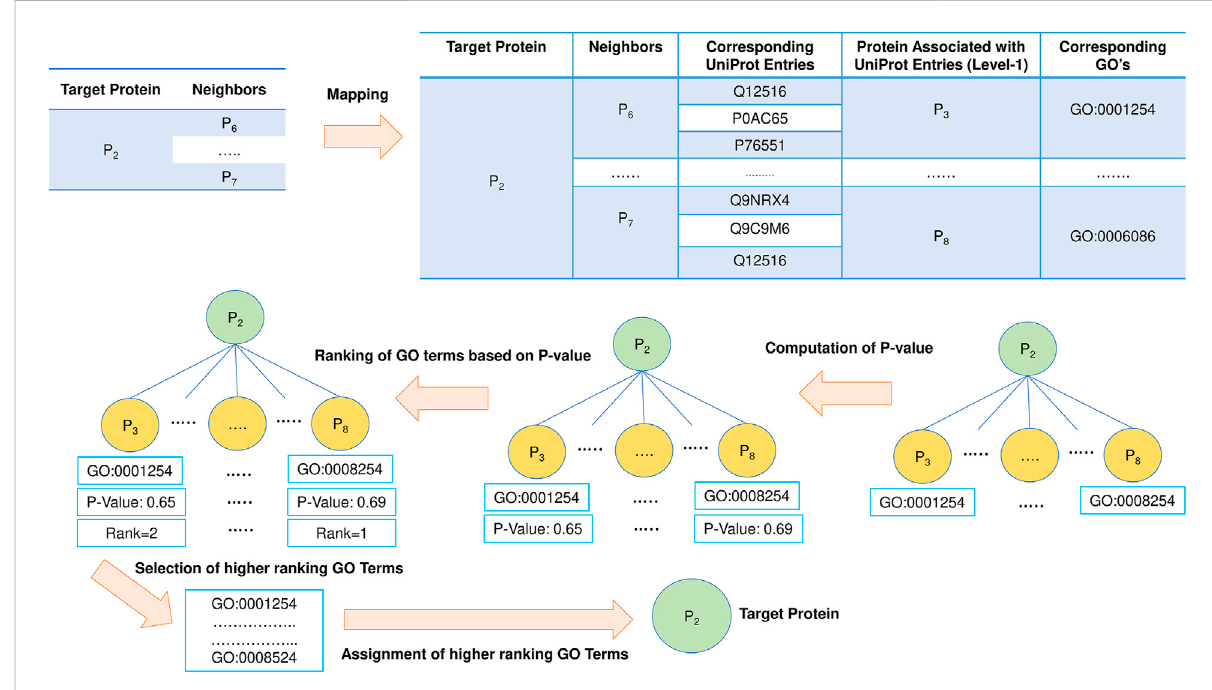
FIGURE 6 PPI network-based protein function prediction. GO term enrichment with p value is vital in this